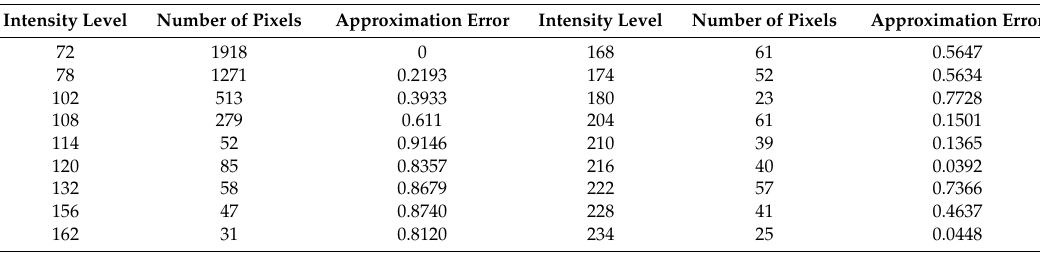
Table 1. List approximation errors, calculated between the original histogram and the approximated histogram for the image shown in Figure